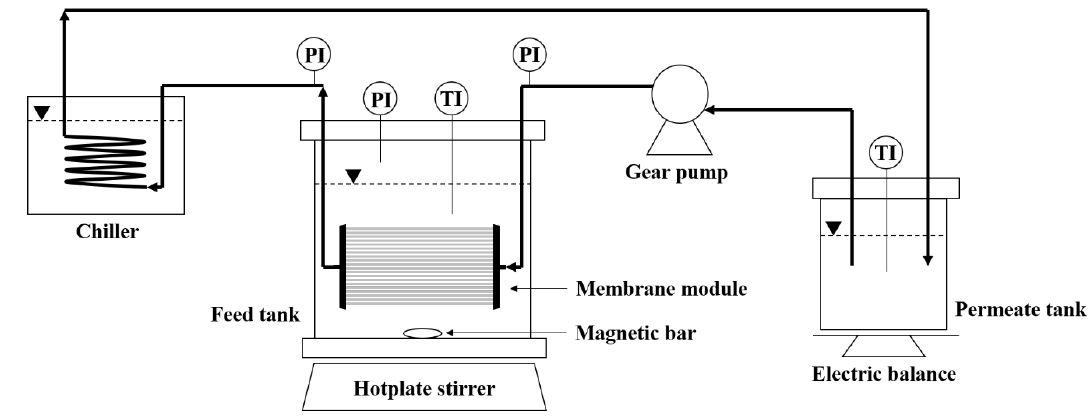
Figure 1. Experimental set-up of laboratory scaled SDCMD process (PI: pressure indicator, TI: temperature indicator).